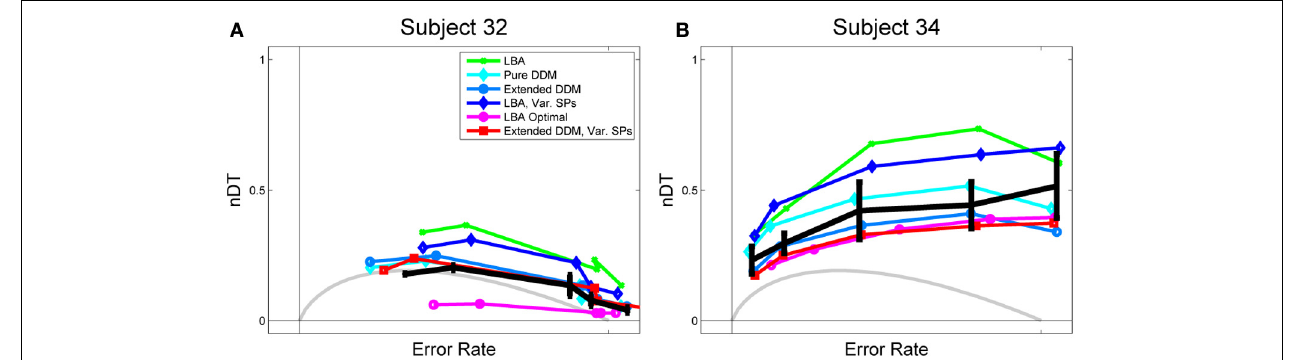
FIGURE 3 | Data and fits to Rmax behavior for (A) a high performing and (B) a low performing participant. Empirical normalized DTs, estimated from mean RT data for the main task and RTs from a signal detection task, are shown in black with standard error bars. OPC for the pure DDM is shown in gray, and OPCs for the LBA, computed as described in section 2.2.3, are